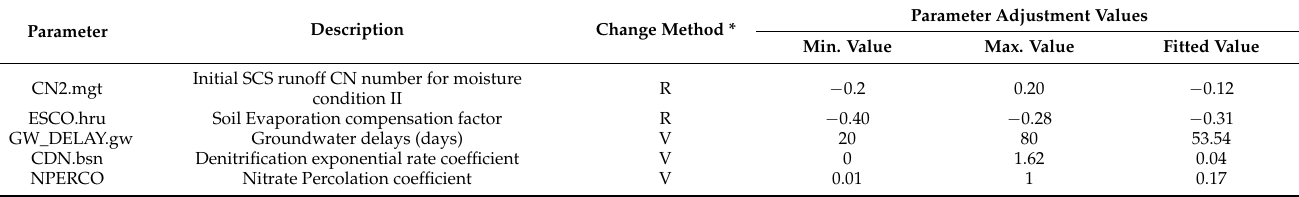
Table 3. The most sensitive parameters during streamflow and nitrate load calibration.